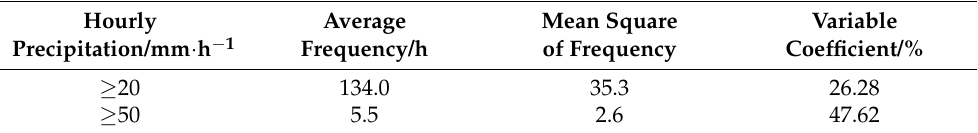
Table 3. Annual mean, mean square error and coefficient of variation of the times of occurrence of heavy precipitation and extreme heavy precipitation.